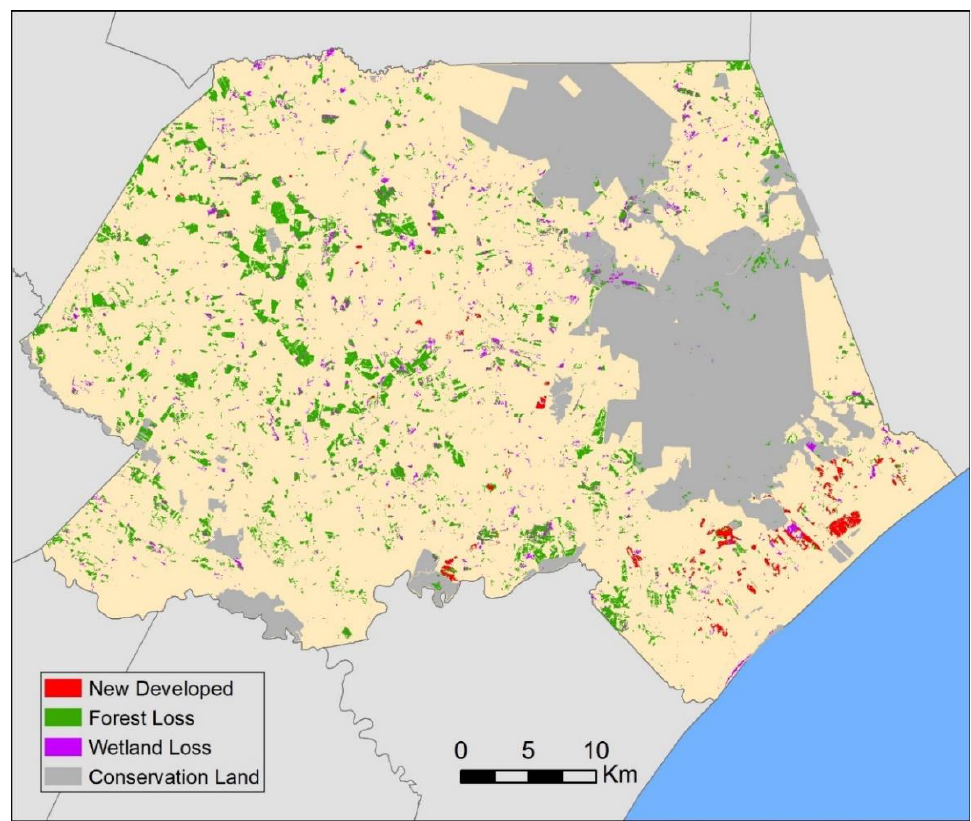
Figure 7. Land cover change (1996 to 2010) illustrating forest (green) and wetland (magenta) loss and undeveloped areas that have become developed (red). (Data Source: C-CAP). Table 4. Percent Change in Land Cover for Pender County and Coastal Pender County (1996–2010) (Data source: C-CAP).